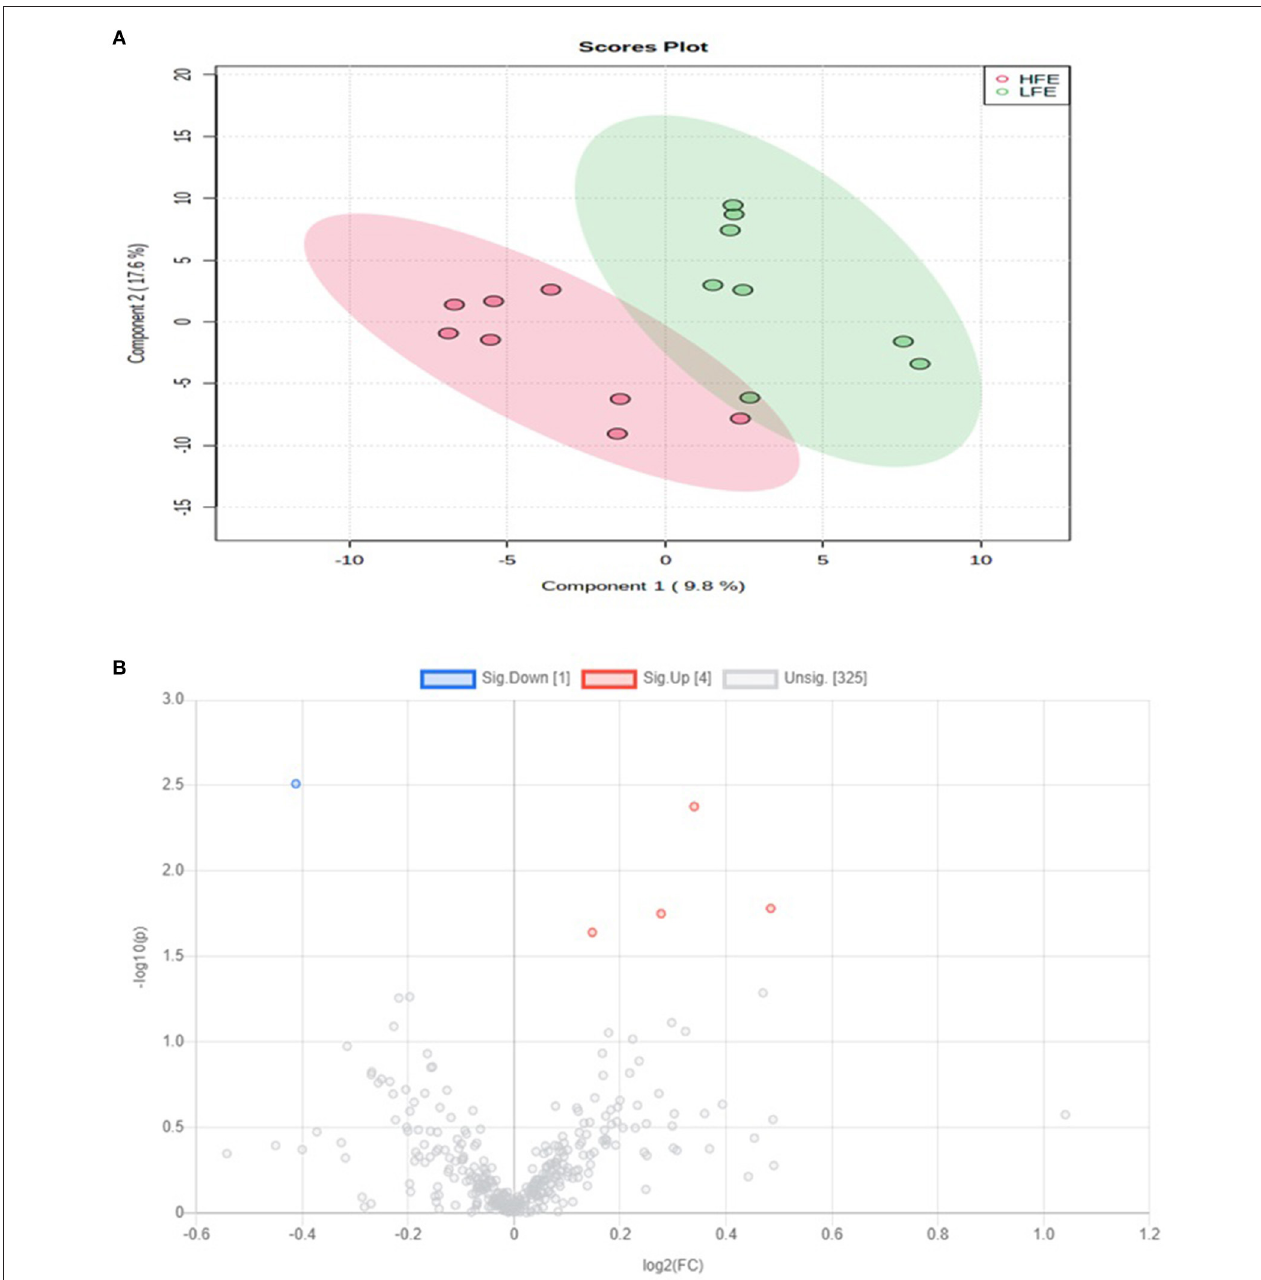
FIGURE 7 | (A) PLS-DA scores plot of carboxyl-acid-metabolome of LFE and HFE steers; (B) Volcano plot showing the differentially abundant carboxylic acid-containing metabolites. Metabolites with false discovery ratio ≤ 0.05 (red or blue) are differentially increased or reduced in HFE, relative to LFE. HFE, beef steers with negative residual feed intake; LFE, beef steers with positive residual feed